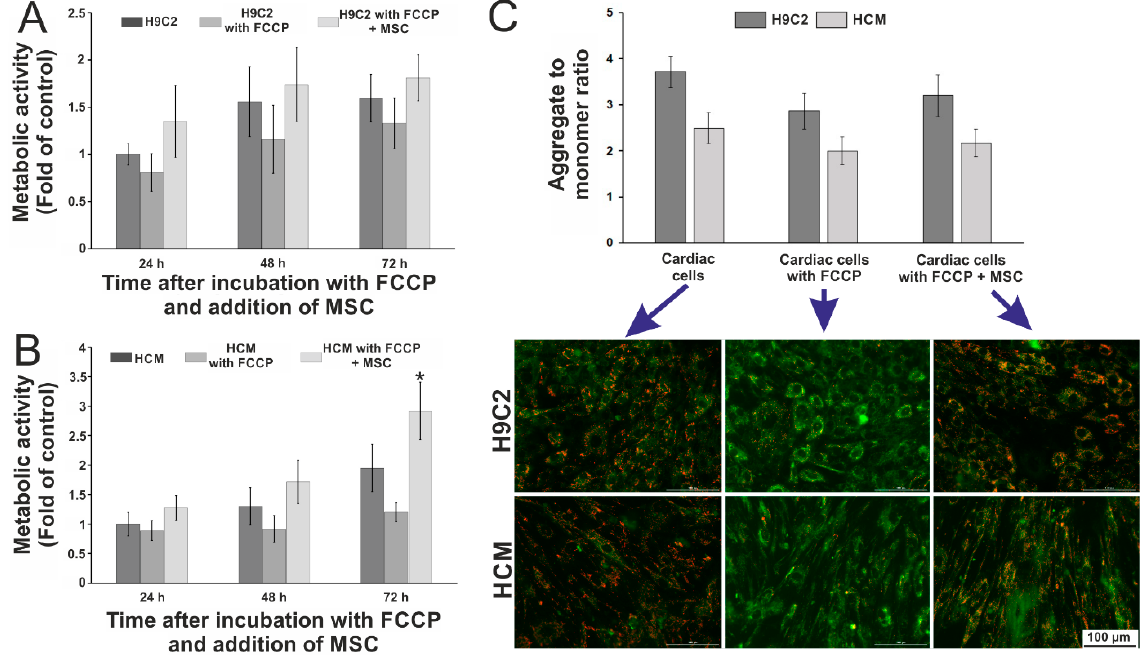
Figure 2. The results of metabolic activity measurements of ( A ) rat cardiomyoblasts (H9C2) and ( B ) human cardiomyocytes (HCM) after incubation with cyanide p-trifluoromethoxyphenylhydrazone (FCCP) and co-culture with mesenchymal stem cells (MSC). ( C ) Comparison of aggregate to monomer ratios for each tested cell culture type: cardiac cells cultured only in a culture medium, cardiac cells incubated with FCCP, and co-culture of cardiac cells incubated with FCCP with MSCs. The pictures of the cells stained with JC-1 dye (red—aggregates, green—monomers) are presented below. N ≥ 3, an asterisk indicates p < 0.05.